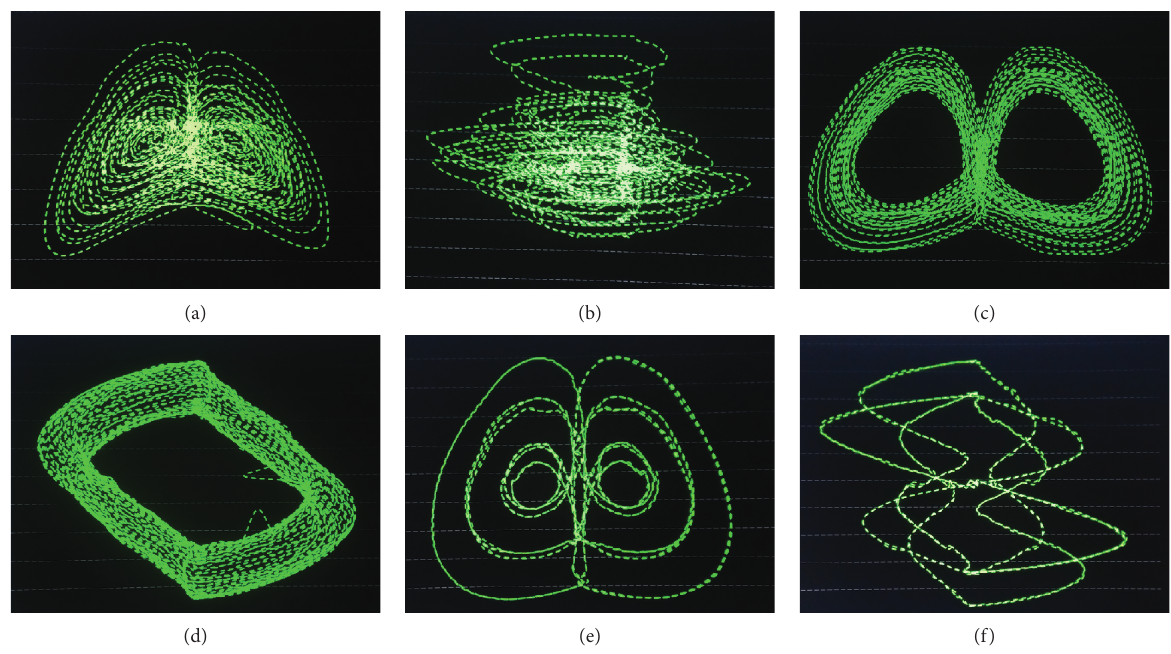
− x and 1 3 − x 1 3